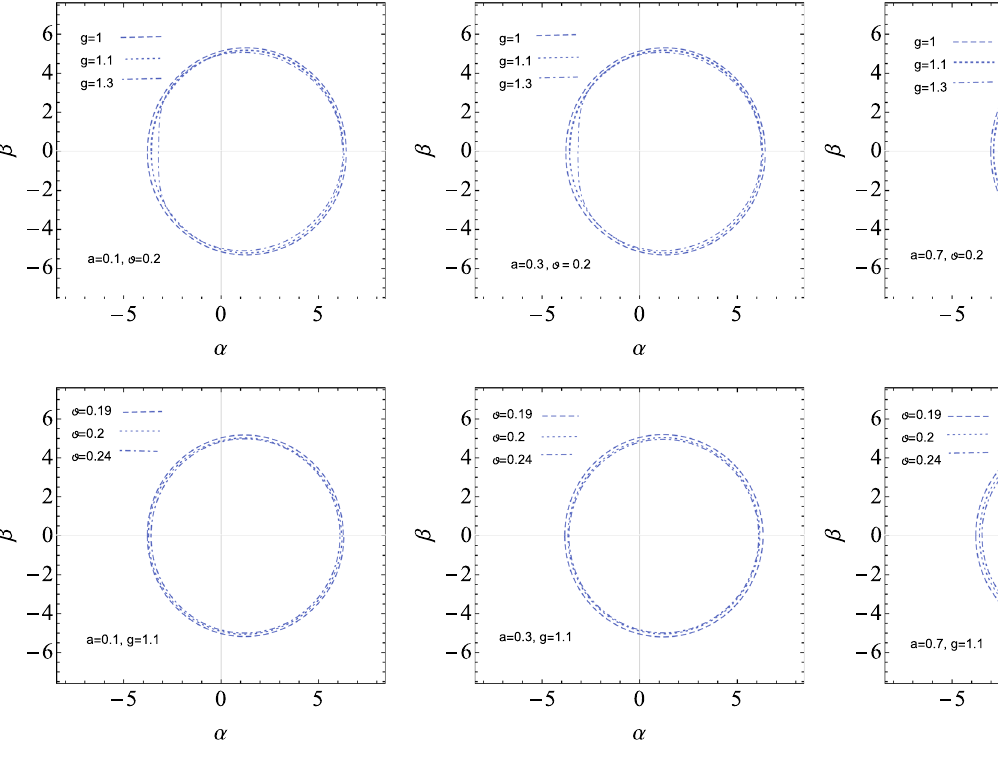
Fig. 4 Shadows of NC Hayward BH for θ = π